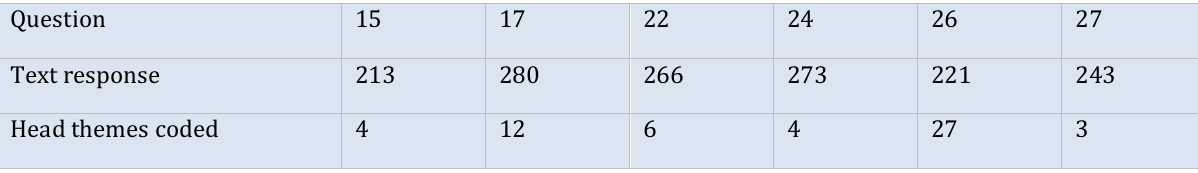
Table 1. Survey key questions, responses and